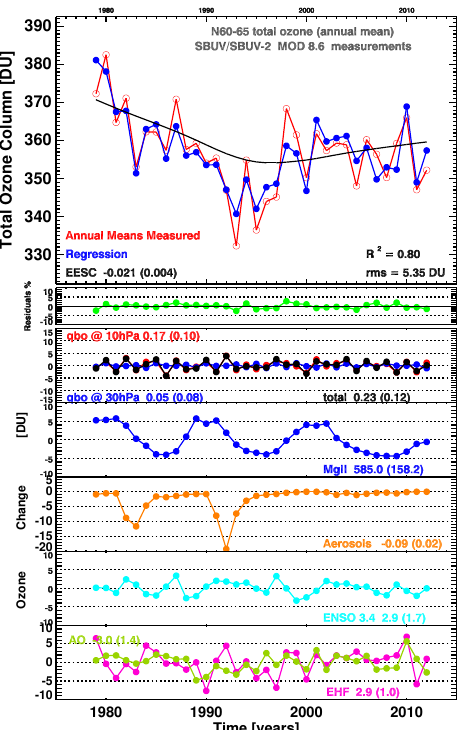
Figure 4. (top panel) R 2 and rms calculated from multiple linear re- gression of 1979–2012 merged SBUV/SBUV-2 Version 8.6 annual mean total ozone from 65 ◦ S to 65 ◦ N (results based on regression Eq. 1). The fitting coefficients of the different explanatory variables used in this study for each latitude band are displayed in respective colours as in Fig. 3. Error bars indicate the statistical significance at two sigma